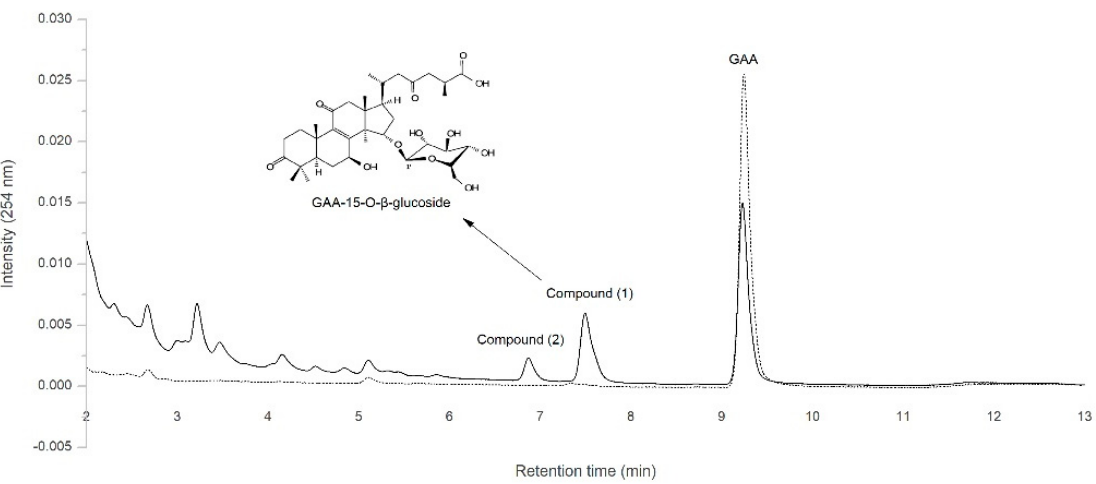
Figure 1. Biotransformation of ganoderic acid A (GAA) by Bacillus subtilis ATCC 6633 after 24 h of incubation (solid line). The figure was modified from Figure 1 of our previous study [17].